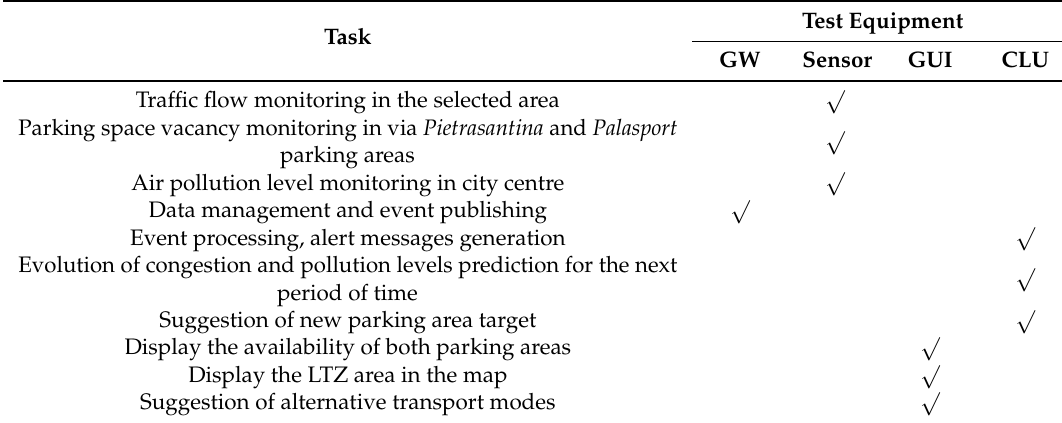
Table 3. Urban scenario related